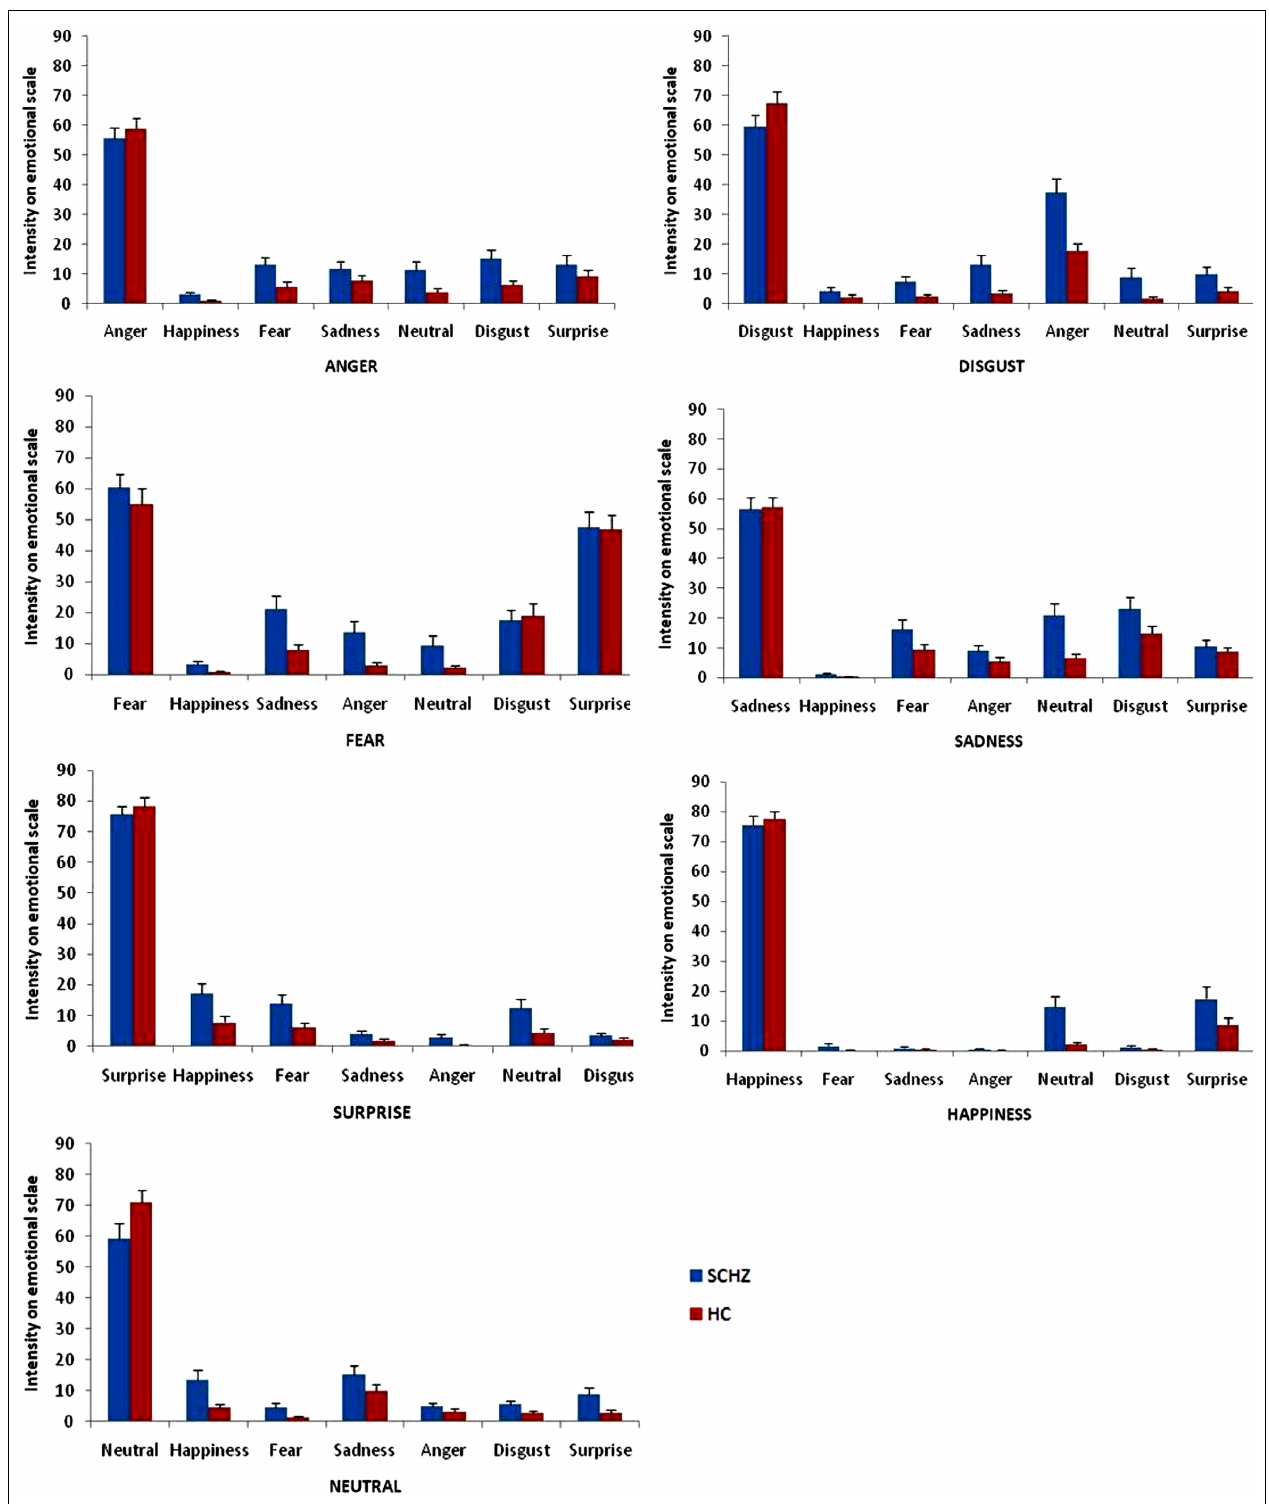
FIGURE 3 | Emotional biases on target and non-target scales for each category of emotional stimuli in the facial emotion recognition task. Error bars indicate standard errors of mean.